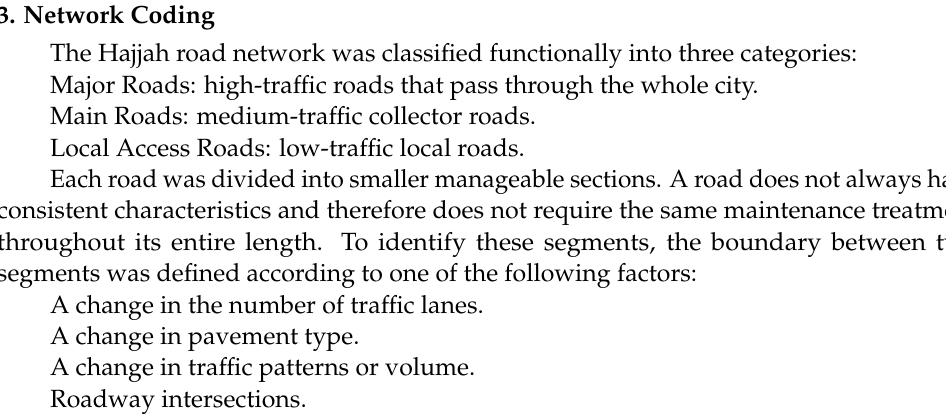
Figure 2. Flowchart of the proposed